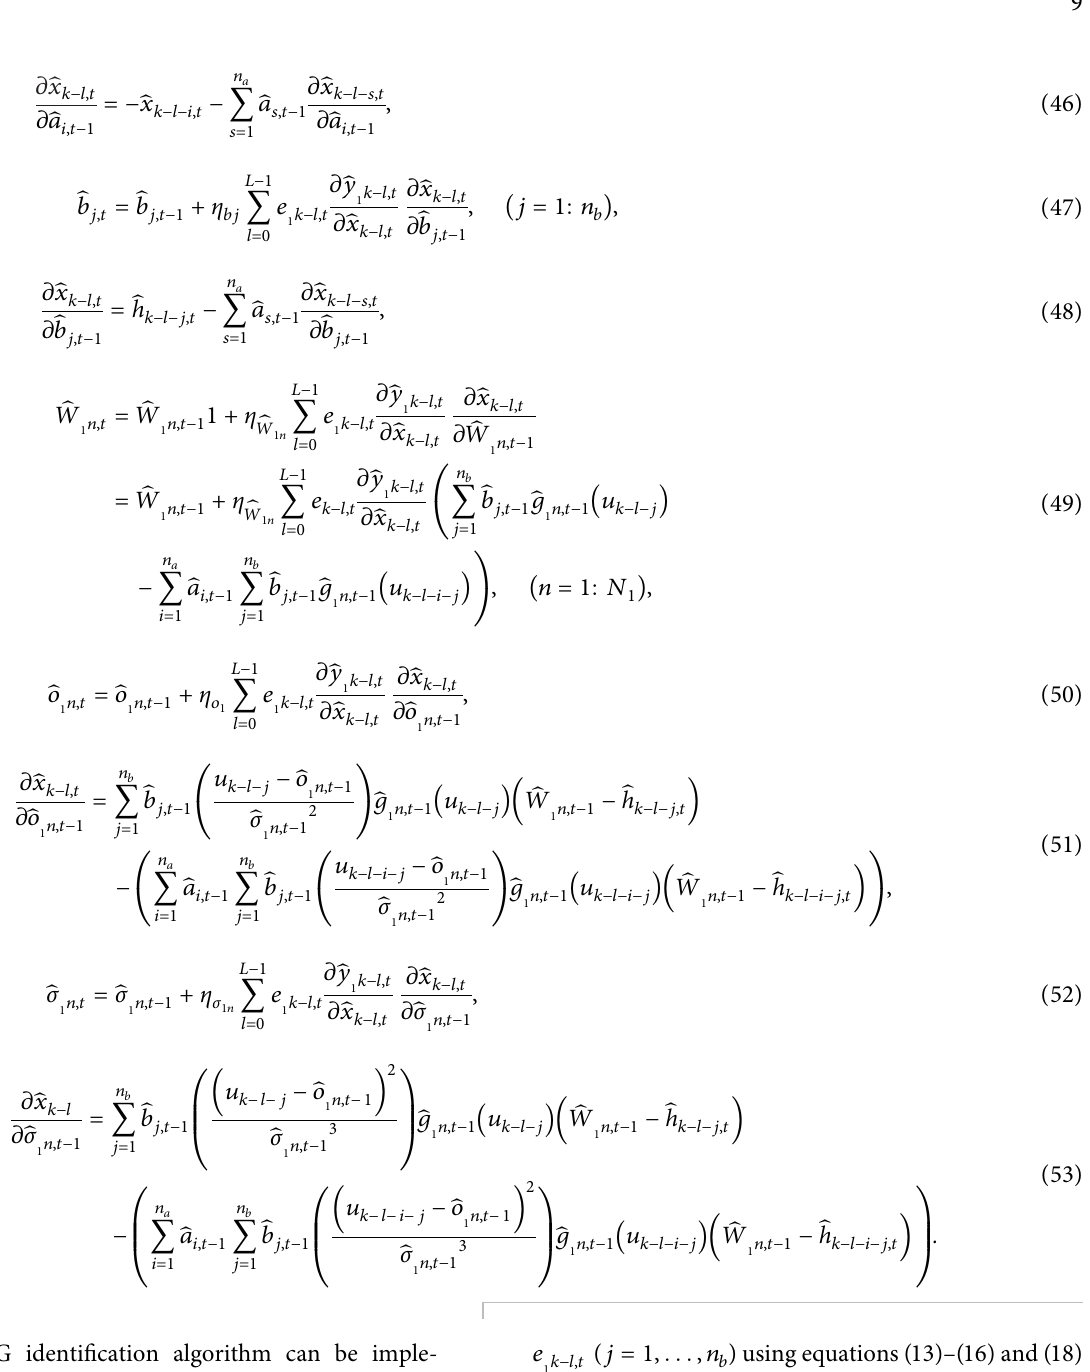
Step 3: adjust the FSOEAHW parameters using equations (40)–(53). Step 4: calculate noise’s estimate by equation (17) replacing k with k-l . Step 5: if the stopping criteria E given by (7) and the parameter than fixed small values, then stop; else, go to step 2; t � t +